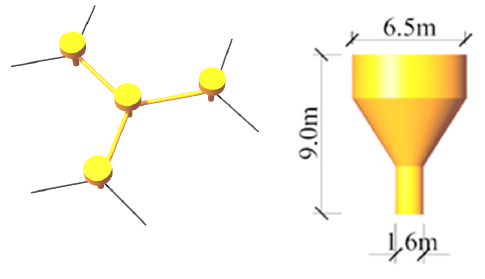
Figure 6. Sketch of the WEC model (from [3]).